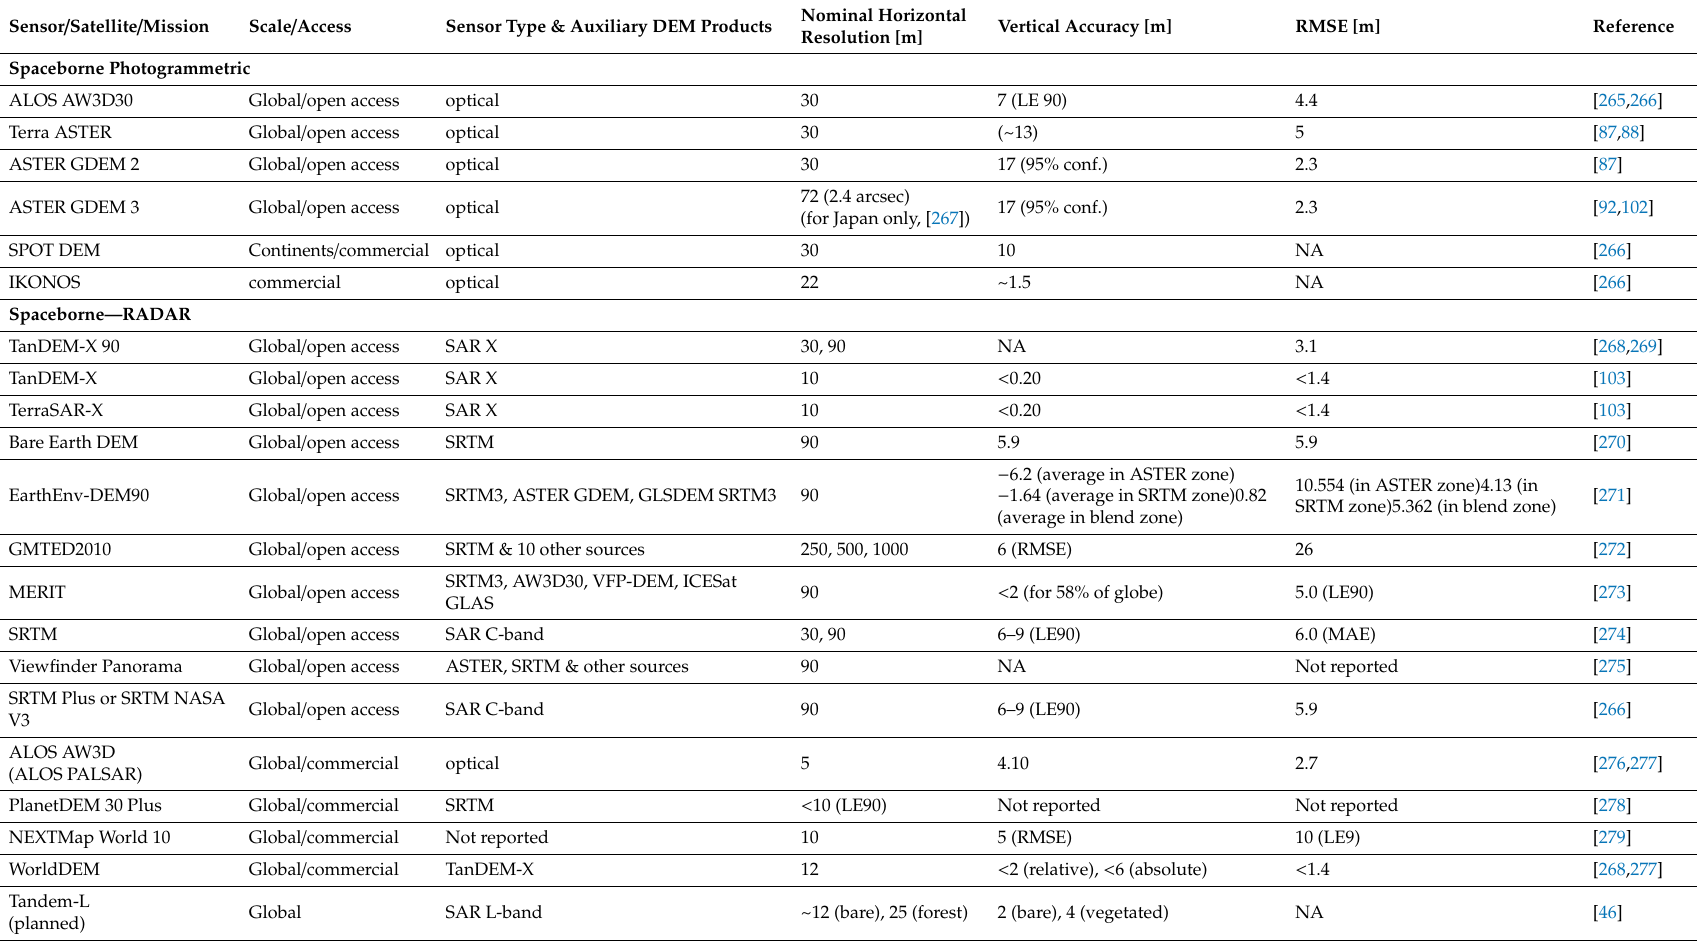
Table 2. Summary of various studies on the accuracy assessment of Digital Surface Models (DSMs, modified after Alganci